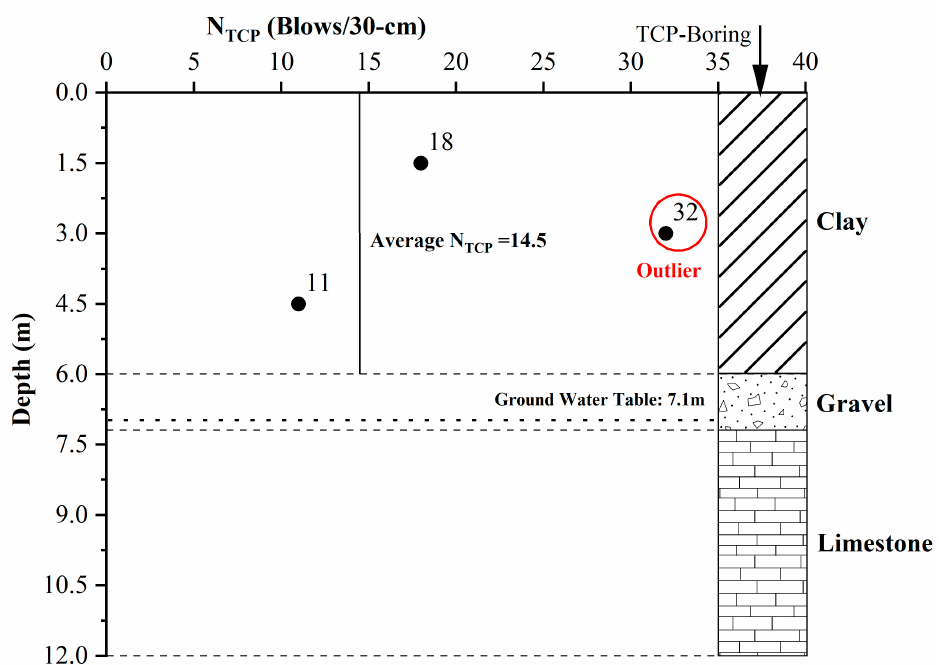
Figure 6. TCP data and boring log of borehole 3 (the circled point is the outlier data). soil samples were collected from the west bank soil slope of the Clear Fork Trinity River.